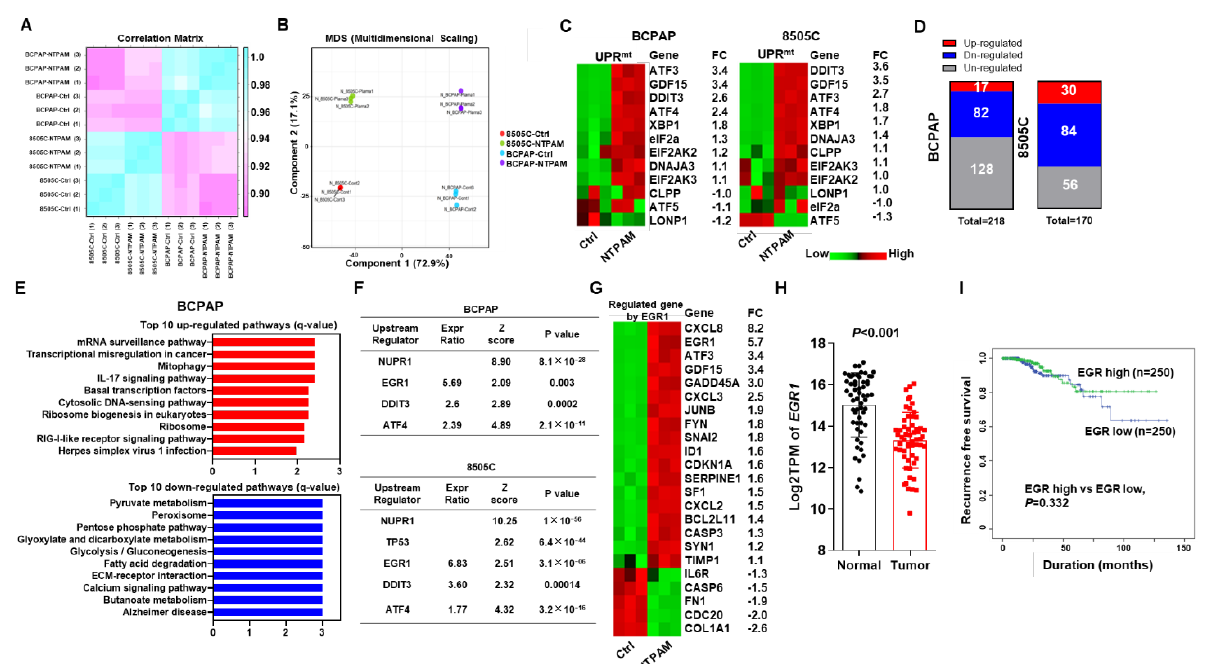
Figure 3. Transcriptome analysis of THCA cells after NTPAM treatment identifies EGR1 as a regulator of thyroid tumorigenesis. ( A ) Correlation matrix of BCPAP and 8505C cells with or without NTPAM treatment. ( B ) Multi-dimensional scaling plots for BCPAP and 8505C cells with or without NTPAM treatment. ( C ) Heatmap analysis of significantly changed genes related to the UPRmt in BCPAP and 8505C cells with p < 0.05 for comparisons of cells with or without NTPAM treatment. ( D ) The total number of significantly enriched KEGG gene sets with corrected p -values < 0.05 according to the Benjamini-Hochberg procedure (considered statistically significant). ( E ) Top 10 upregulated pathways and top 10 downregulated pathways in BCPAP cells in relation to NTPAM treatment. ( F ) Upstream regulators in relation to NTPAM treatment in BCPAP and 8505C cells via IPA. ( G ) Heatmap analysis of significantly changed genes related to EGR1 with p < 0.05 compared to BCPAP cells with or without NTPAM treatment. ( H ) Box plot of log2TPM of EGR1 values between normal and tumor samples in the TCHA cohort. The significance for between group differences was evaluated using logrnak test. ( I ) Disease-free survival in relation to EGR1 expression in the THCA cohort. TPM: transcripts per million.